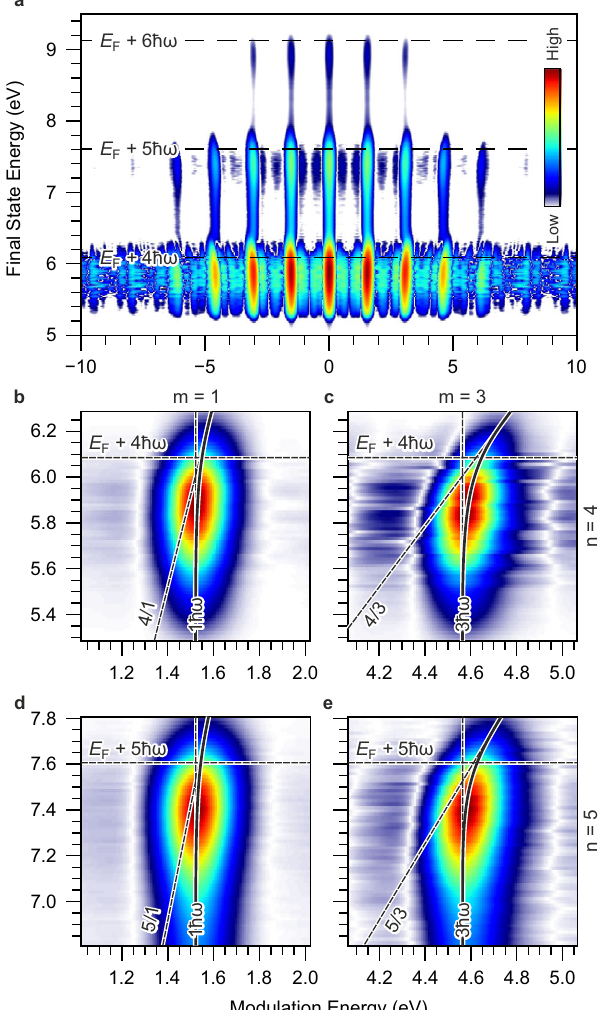
Fig. 4 Coherent two-dimensional plasmoemission spectroscopy. a Coherent two-dimensional plasmoemission spectrum computed by a Fourier transform of the data in Fig. 3b along the delay axis, represented on a logarithmic false-color scale (see color bar in panel a ). b – e , Enlarged views of different coherences in the electron emission process extracted from panel c , shown in a linear false-color scale (colors comparable to the color scale in panel a ). b , c show the m = 1 and m = 3 coherences in 4 th order electron emission ( n = 4), whereas d , e show the same coherences in 5 th order emission ( n = 5). The tilts of the coherences match the expected asymptotic tilts starting from the position of the band minimum of the Shockley surface state (SS). The solid black lines indicate this behavior and are intended as guides to the